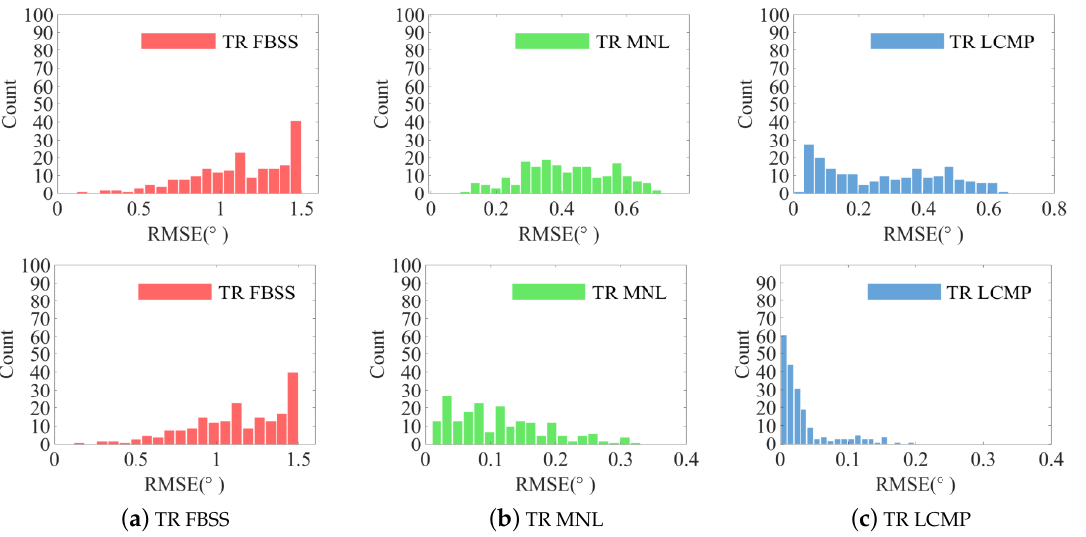
Figure 3. RMSE histograms of the three algorithms (The top subplots are RMSE histograms of the three algorithms at SNR = 0 dB, while the bottom subplots are RMSE histograms of the three algorithms at SNR = 10